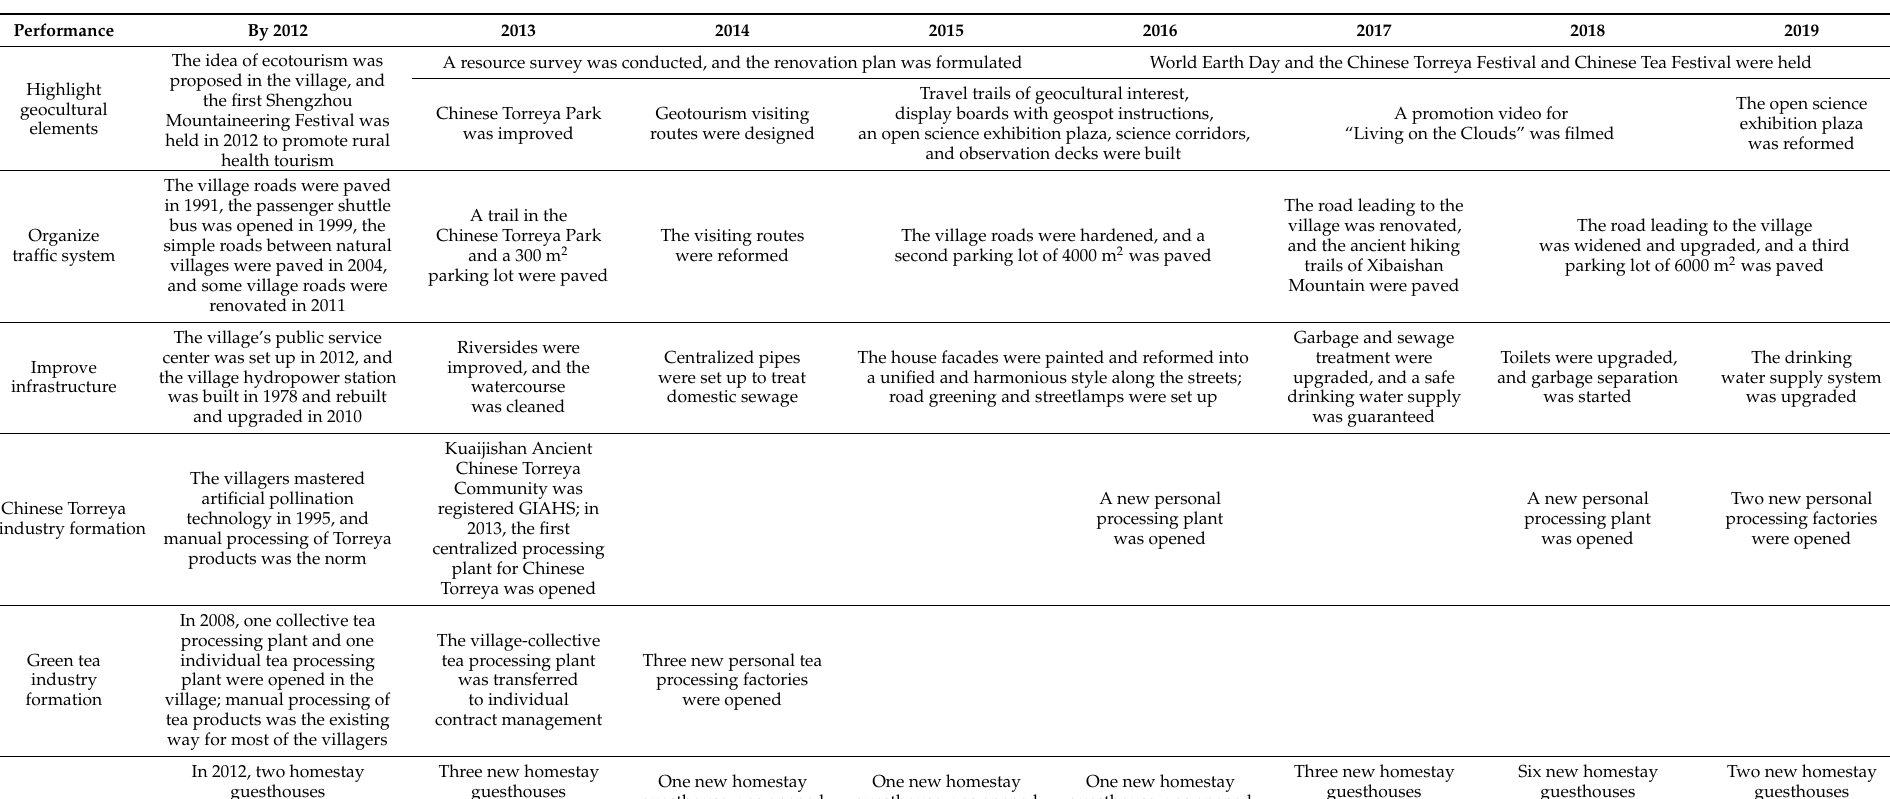
Table 3. The improvement work of Baiyankeng geocultural